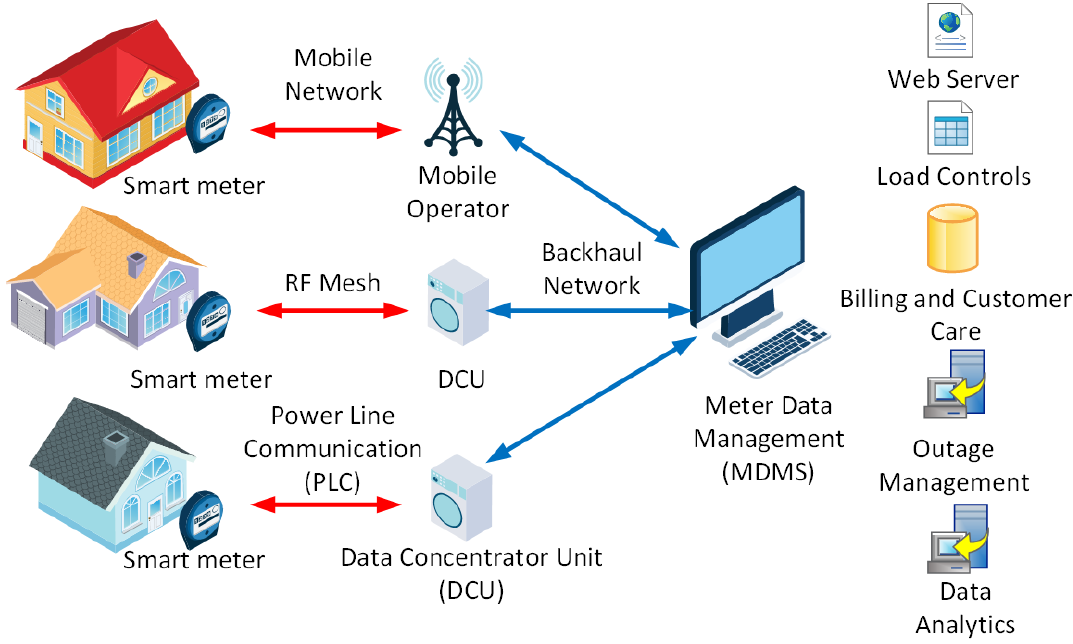
Figure 1. The AMI